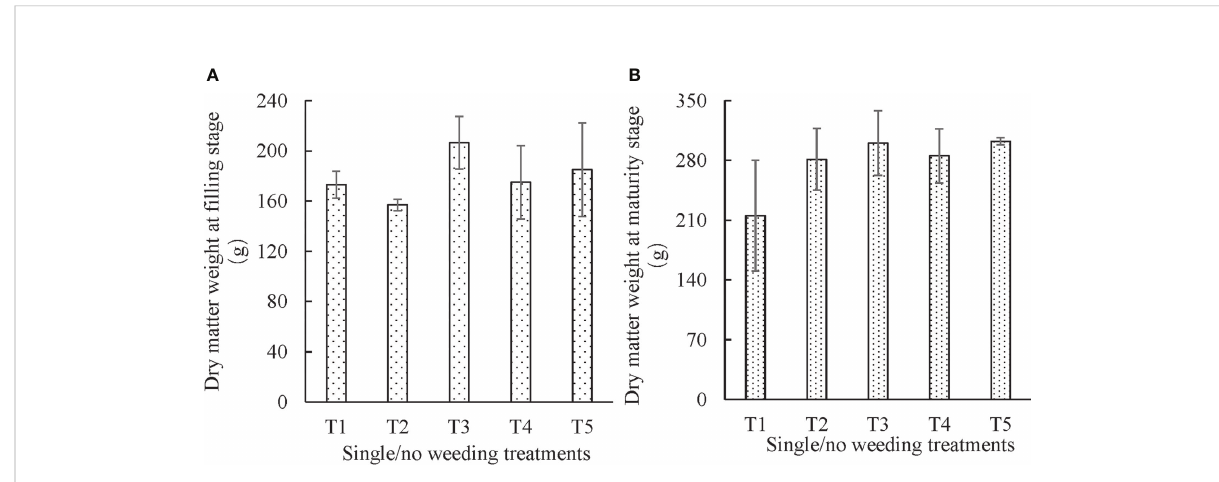
FIGURE 3 Effects of different single/no weeding treatments on dry matter weight of maize (A) , at fi lling stage and (B) , at maturity